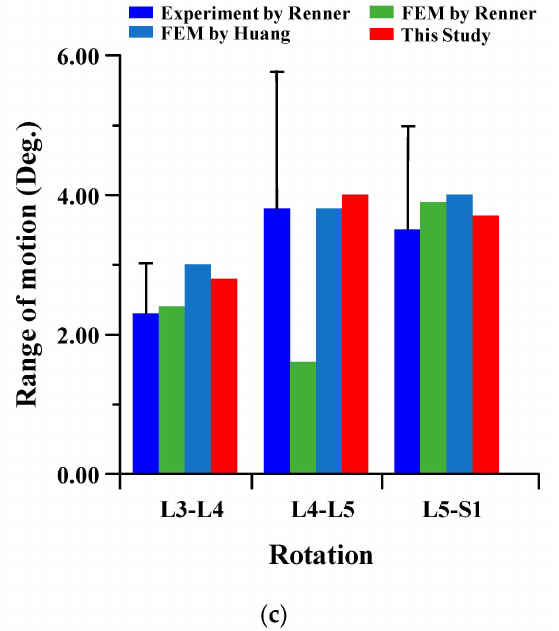
Figure 3. Comparison of range of motion (ROM) of intact FE model between the current study and conventional studies of Renner et al. and Huang et al.: ( a ) flexion-extension; ( b ) lateral bending; ( c ) rotation.